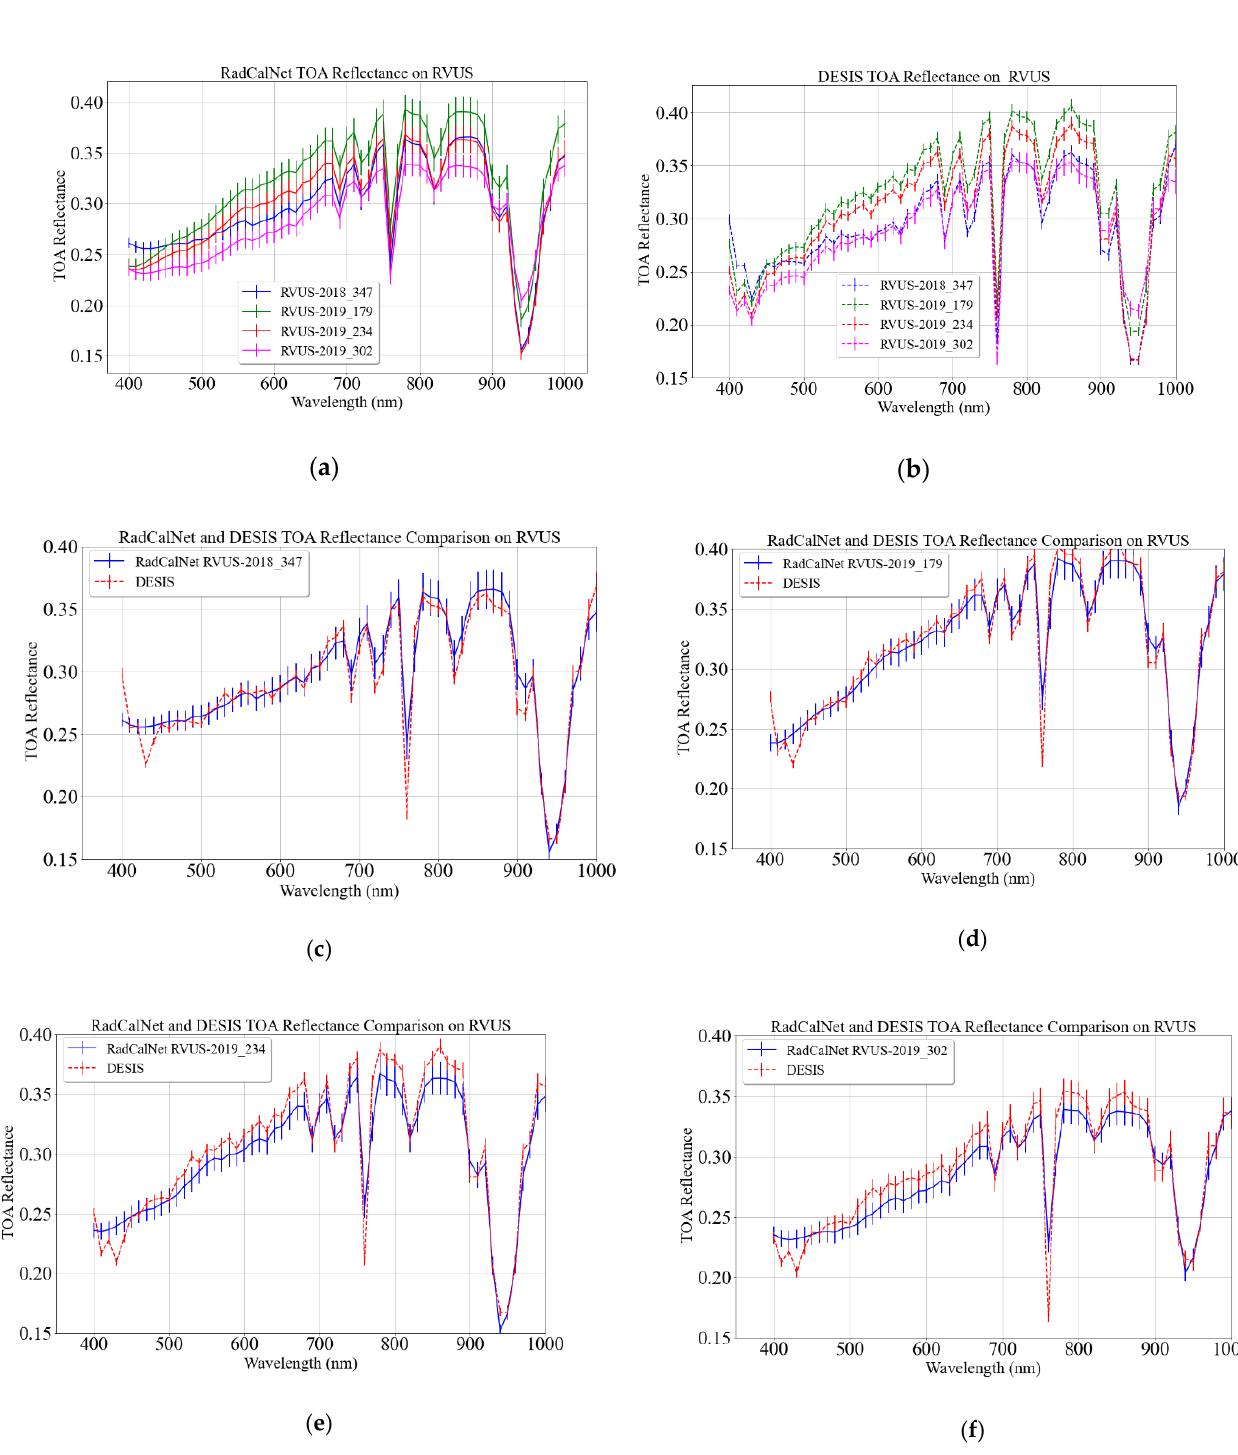
Figure 6. RVUS TOA reflectance, RadCalNet ( a ) and DESIS ( b ). RadCalNet and DESIS individual spectrum comparison ( c – f ). DESIS acquisition dates and RadCalNet measurement dates are expressed in (yyyy_day of year).